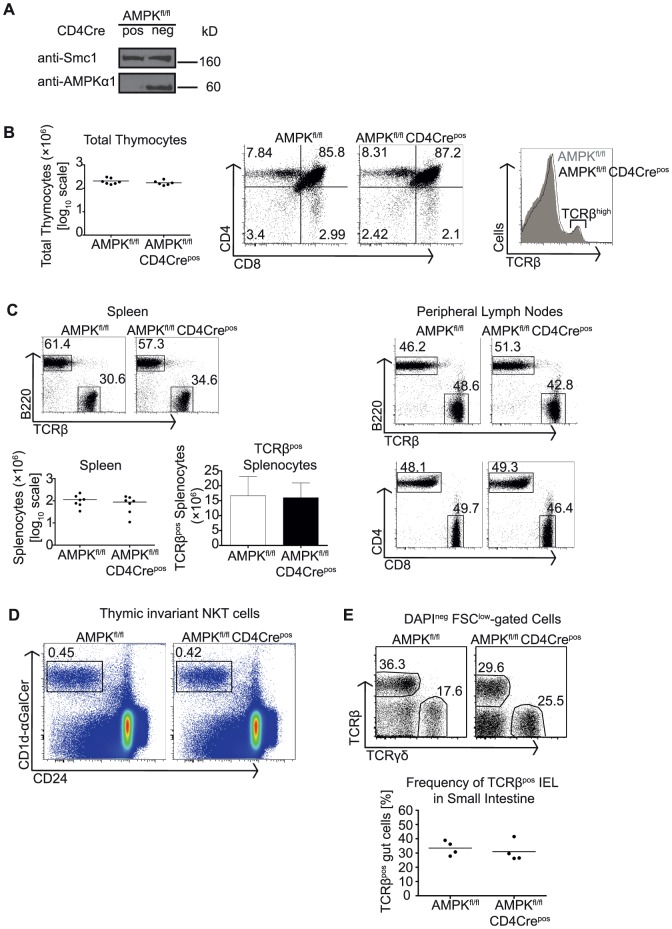
Development and accumulation of T cells does not require AMPKα1.(A) CD4pos thymocytes from AMPKα1fl/fl CD4Creneg or CD4Crepos thymi were purified and lysed as described in Figure 1. Immunoblots were probed for AMPKα1 and Smc1 as control for equal loading. Data are representative of at least two independent experiments. (B and C) Thymi and secondary lymphoid organs were isolated from AMPKα1fl/fl CD4Creneg and CD4Crepos mice and analysed as described in Figure 1. Quantification of cell numbers in thymi (B) and spleens (C) are also shown. Histograms are representative for at least three mice in panels B and C. Numeric dot plots and bar graphs summarise data from at least five to six mice. Mice were analysed between 60–80 days of age. (D) iNKT cells were identified as CD24low CD1d-αGalCerpos thymocytes isolated from AMPKα1fl/fl CD4Creneg or CD4Crepos thymi. Flow cytometric histograms and frequencies shown are representative of at least three independent experiments. (E) TCRβpos and TCRγδpos T cells were identified from cell preparations isolated from the epithelial layer of small intestines from AMPKα1fl/fl CD4Creneg and CD4Crepos mice followed by flow cytometric analysis as described in Figure 2. Dot plot summarises frequencies of TCRβpos IEL cells from four different mice. Histograms are representative of four independent analyses.